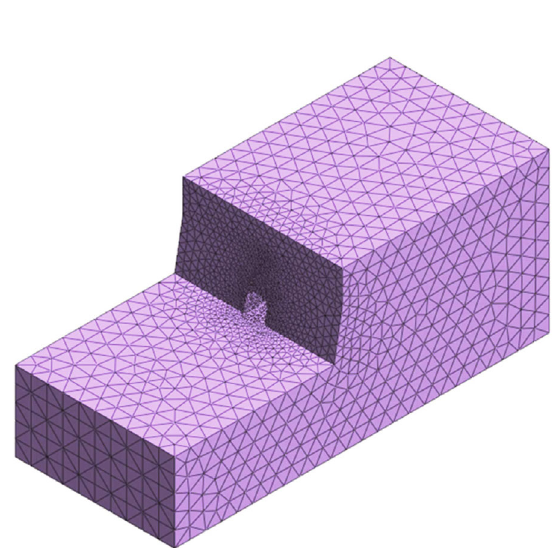
Figure 4: Calculation model.